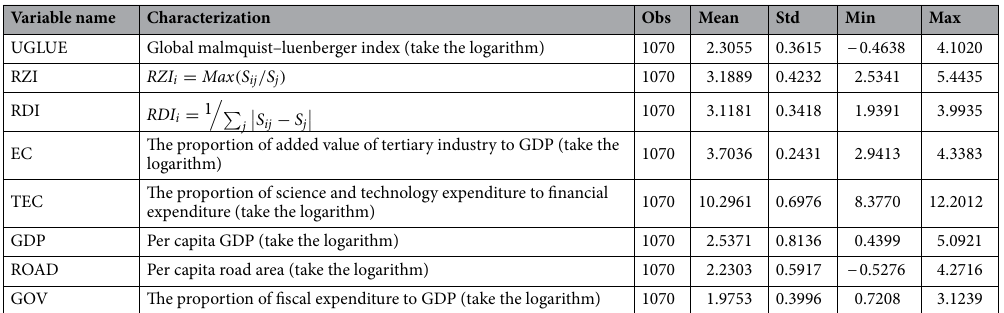
Table 2. The descriptive statistics of variables.